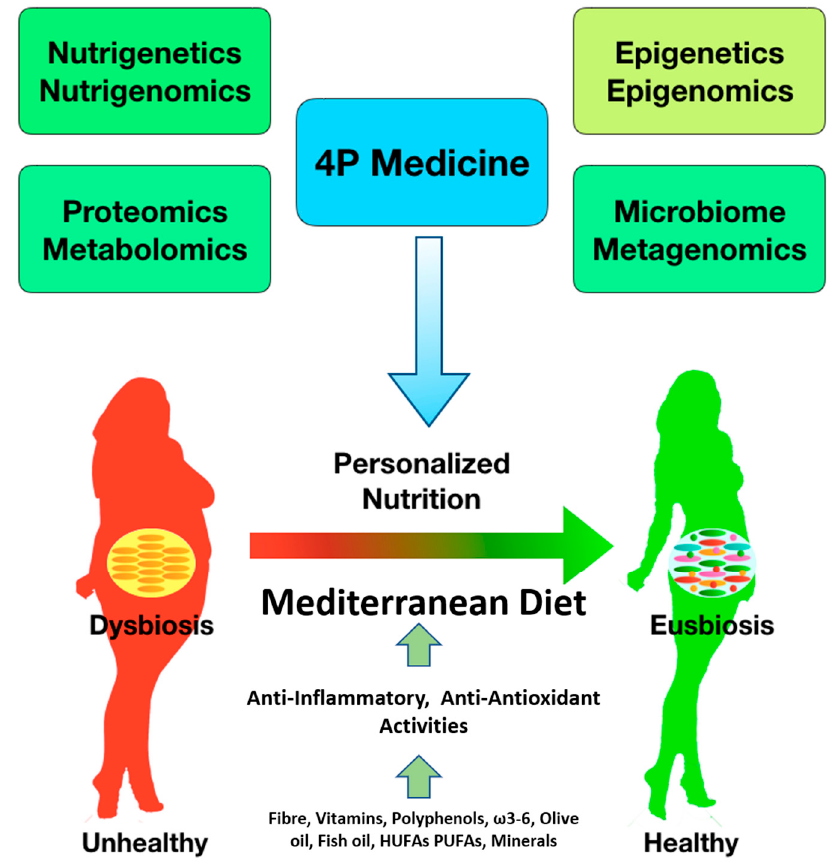
Figure 1. 4P medicine, in the era of -omics sciences; to switch from an unhealthy condition of dysbiosis to a healthy condition of eusbiosis. 4P: Predictive, personalized, preventive and participatory; HUFAs: h-3 highly unsaturated fatty acids; PUFAs: polyunsaturated fatty acids.